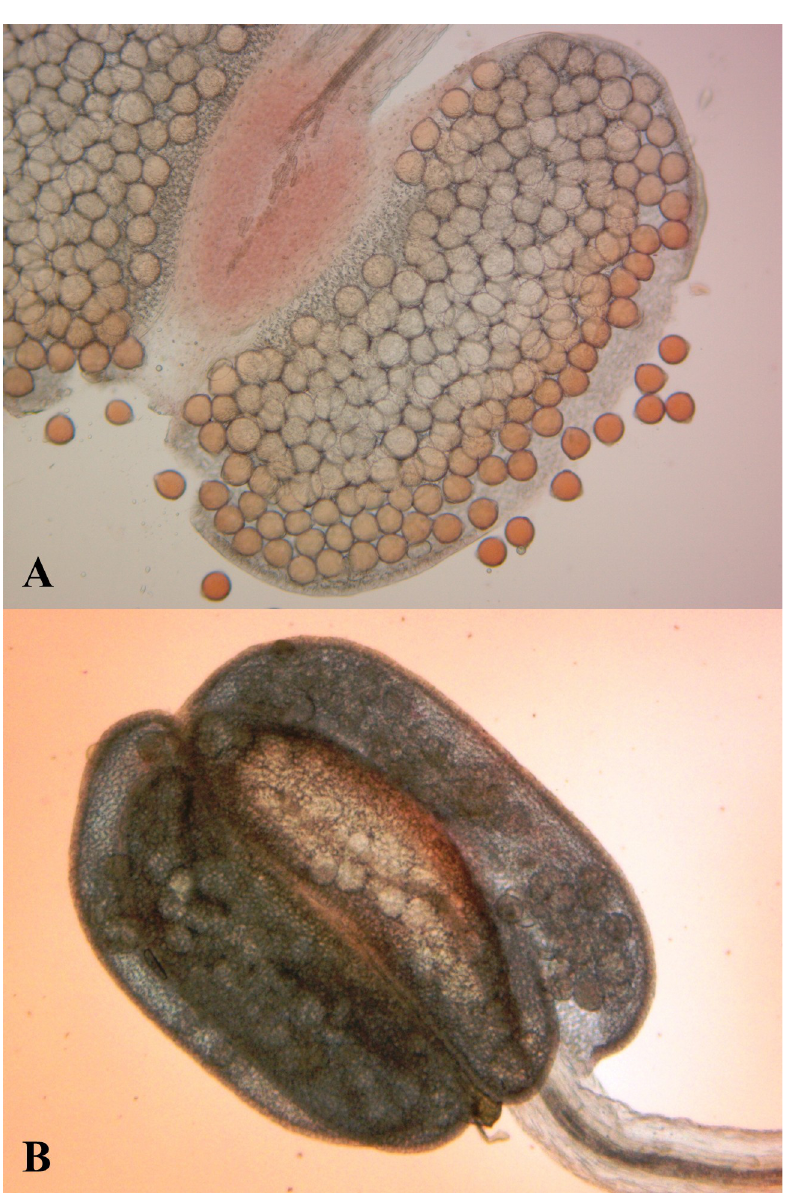
Fig 1. Evaluation of anther indehiscence in common bean. A: Dehiscent anthers, B: Indehiscent anthers. HYRBEAN image analysis workflow works as follows. Image segmentation to identify pol- len grains was achieved with the following steps using OpenCV software package [28]. a) each input RGB image is converted to grayscale; b) then, the Sobel filter in x, y directions is employed for highlighting the pollen grains present on the image; c) to detect connected areas, the canny filter followed by a close morphological operation are applied; d) sequentially, the watershed segmentation algorithm is applied to separate the touching regions; e) finally, the contours are extracted utilizing the find contours function with the OpenCV API. Only the contours where the circularity and area have higher significance scores than 0.5 and 100, respectively, are considered. The results of the segmentation can be observed in Fig 3B.